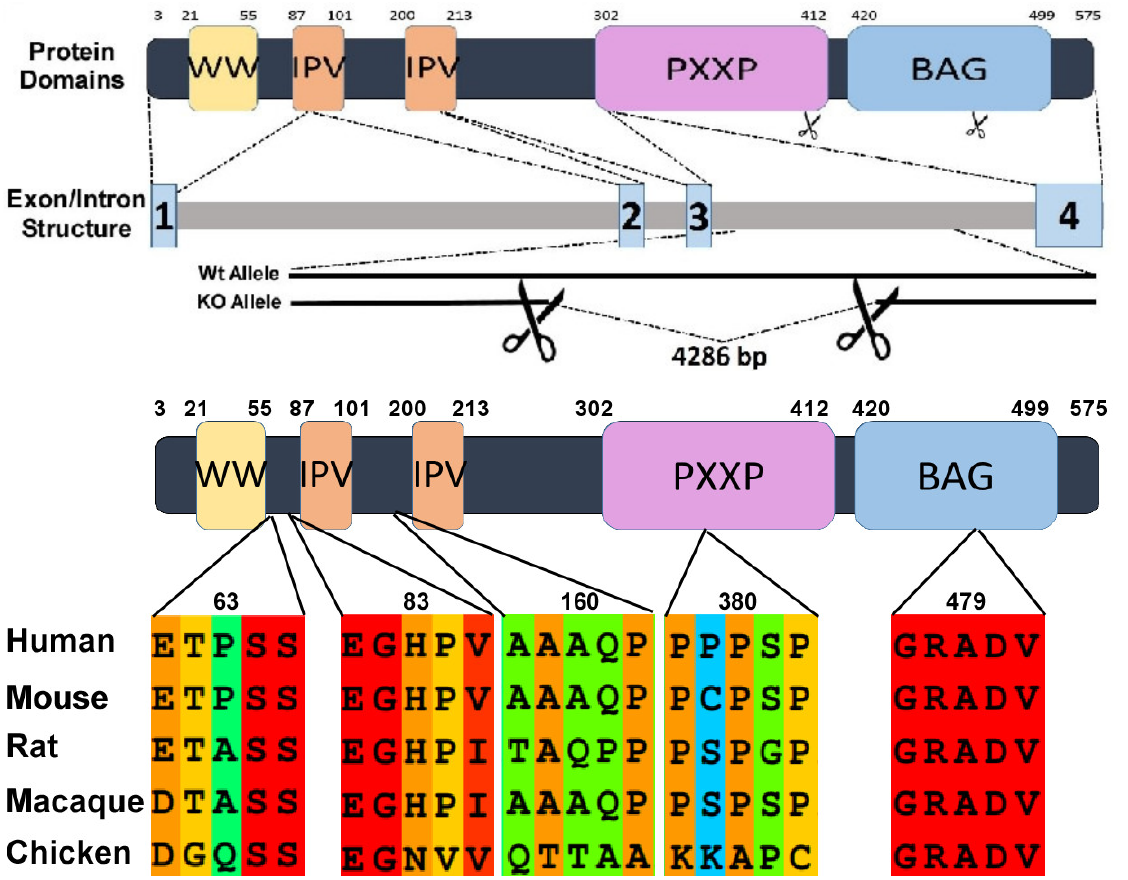
Figure 1. Structure of BAG3 : BAG3 is a constitutively expressed, multifunctional, and ubiquitous protein that is most abundant in the heart, the skeletal muscle and the central nervous system. The top panel shows the structure of the BAG3 gene and the cleavage sites that result in the transcription of the four exons that are found in the mRNA that translates into the mature protein seen in the lower panel. The “WT” indicates the structure of the wild type gene or protein. The “KO” indicates the removal of a region of BAG3 to create a knock-out phenotype in a mouse. The lower panel shows the locations of the amino acid changes that occur as a result of informative single nucleotide polymorphisms that change the amino acid translated from those genetic variants. To date, these novel variants have only been found in individuals of African ancestry and not in individuals of European ancestry. They do not alter the development of a dilated cardiomyopathy, but if present, they increase the risk of a patient who carries one of these variants either dying or developing worsening heart failure by almost two-fold.